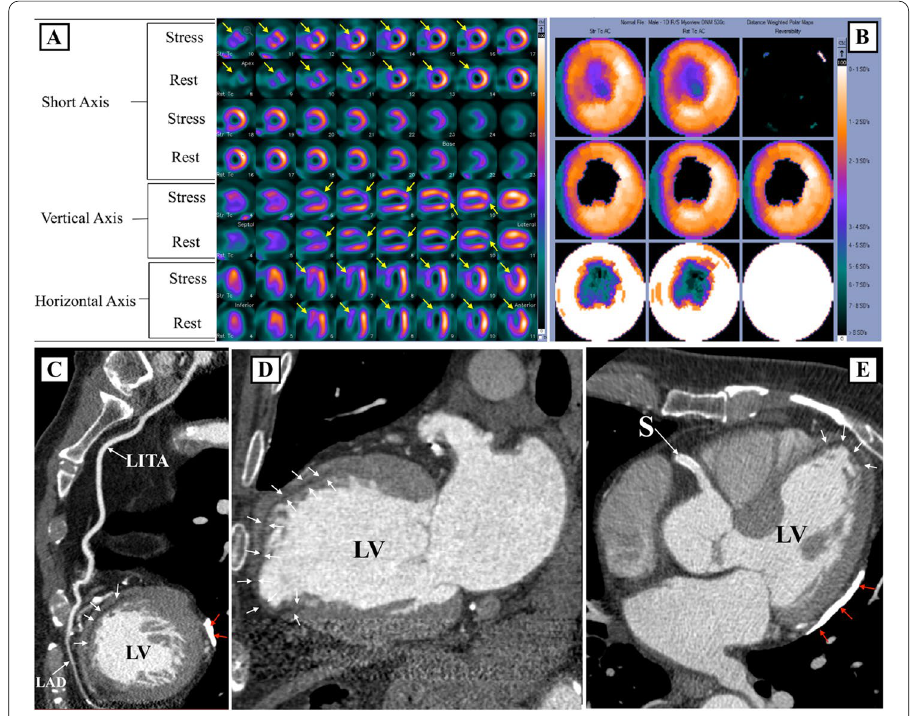
Fig. 4 A SPECT images, B polar maps at stress (upper panel) and rest (lower panel), C – E computed tomographic angiography images. LAD, left anterior descending artery; LITA, left anterior thoracic artery; LV, left ventricle; S,